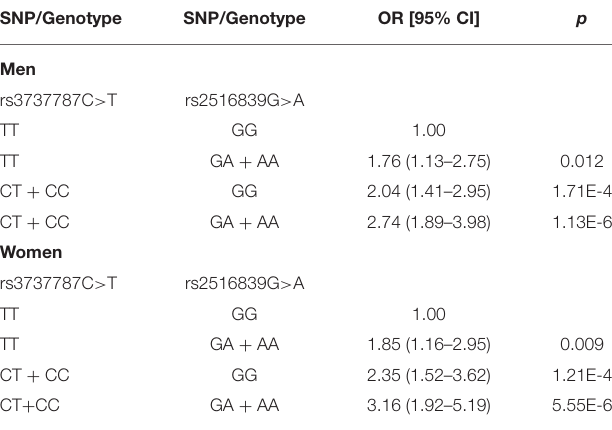
TABLE 8 | Interactions of the rs3737787 and rs2516839 SNPs on the risk of EOCAD.